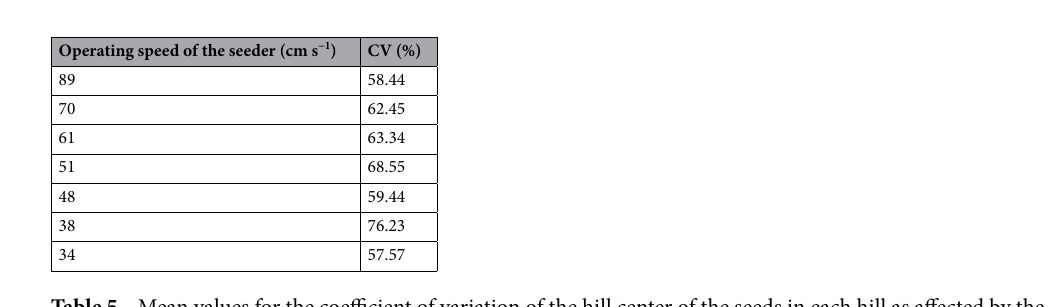
Table 5. Mean values for the coefficient of variation of the hill center of the seeds in each hill as affected by the levels of operating speed.